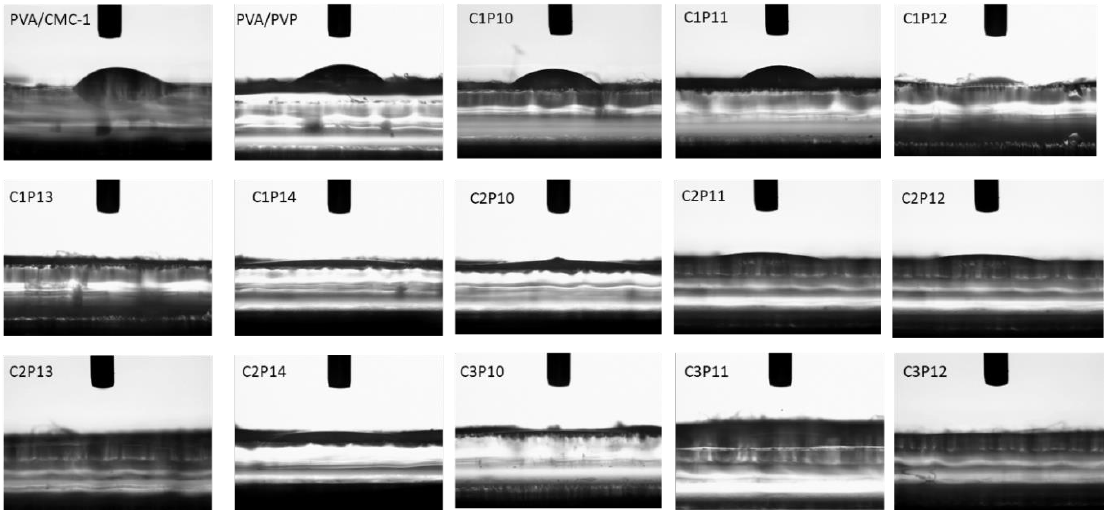
Figure 4. Water contact angles (WCA) for PVA/CMC, PVA/PVP, and PVA/PVP/CMC (C1P10 to C3P12) nanofibers: Effect of variation in weight ratios of PVP and CMC on water affinity of nanofibrous mats